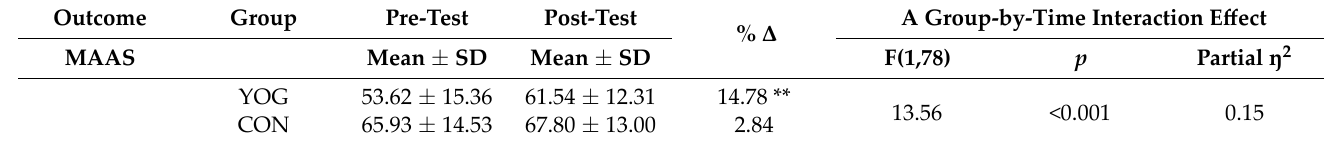
Table 7. MAAS scores at pre‑ and